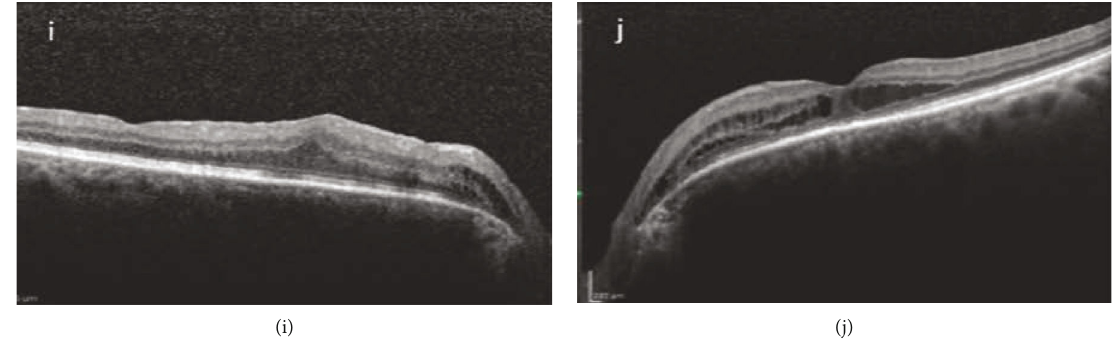
Figure 1: OCT images at presentation showing ERM in the RE (a) and CME in the LE (b). FA of the RE (c) and LE (d) showed very mild hyper fl uorescence in the fovea of the LE and mild late staining of the ONH, temporally, in both eyes. Three months later, the OCT of the RE remained unchanged (e), while in the LE there is additional SRF in the fovea (f). OCT images after ERM peeling in RE (g) and topical treatment with dexamethasone and nepafenac drops in the LE (h); the accumulations of SRF and IRF have almost completely resolved. OCTs six months later: the RE (i) is stable, while CME has reappeared in the LE